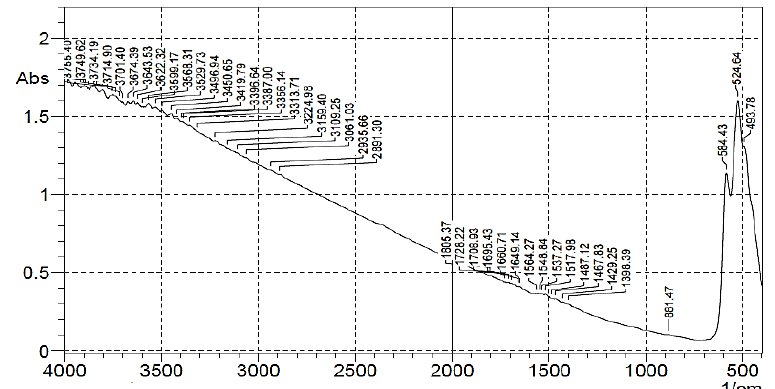
Fig. 2. FT-IR Spectrum of prepared CuO